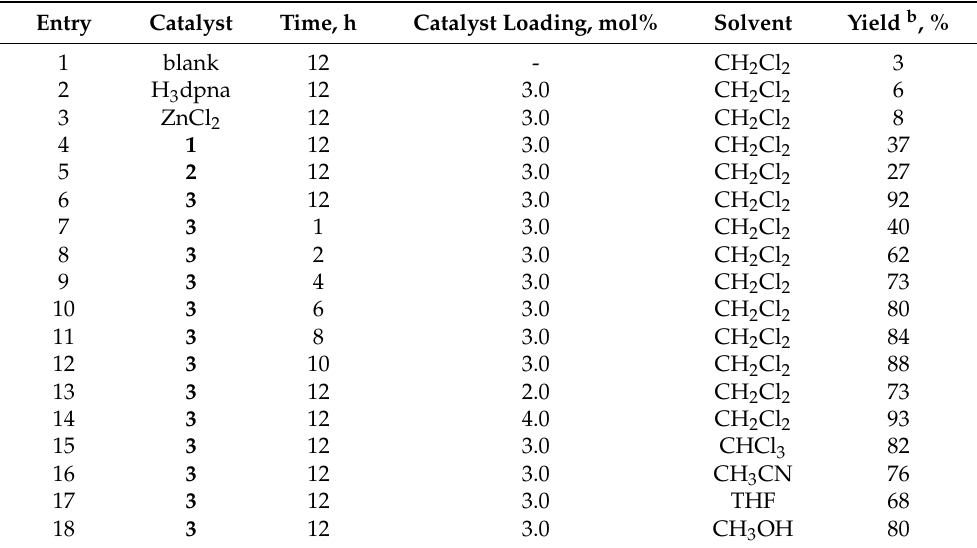
Figure 3. Structural fragments of 3 . ( a ) Coordination environment around Zn(II) atoms; H atoms are omitted for clarity. Symmetry codes: i = – x , – y + 1, – z ; ii = – x + 1/2, y –1/2, – z + 1/2. ( b ) 2D metal–organic layer; view along the a axis. ( c ) Topological representation of 2D layer with an hcb topology; view along the a axis; Zn(II) centers (cyan balls), centroids of µ 4 -dpa 4 − nodes